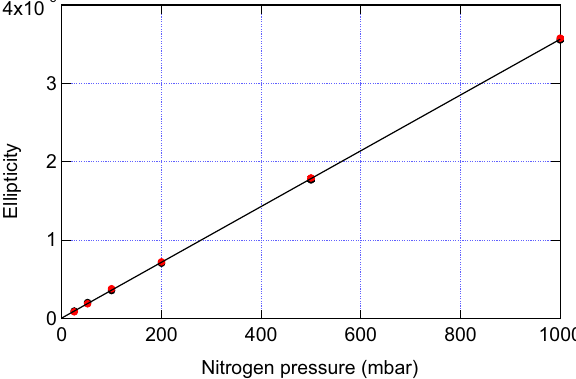
Fig. 12 Global linear fit of the 4 ν P + 2 ν B α and 4 ν P + 2 ν B β ellipticity data of Fig. 11 as a function of the gas pressure. Fit parameters are: ( 3 . 555 ± 0 . 010 ) × 10 − 9 /mbar slope, ( 10 ± 5 ) × 10 − 9 intercept and χ 2 / d . o . f = 9 . 4 / 10. The statistical 1 σ uncertainty for each data point is σ ψ = 1 . 3 × 10 −